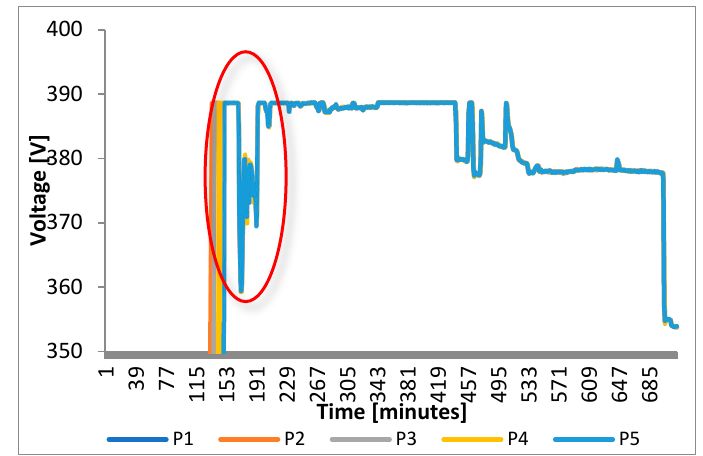
Figure 4. Voltage variations during one day.